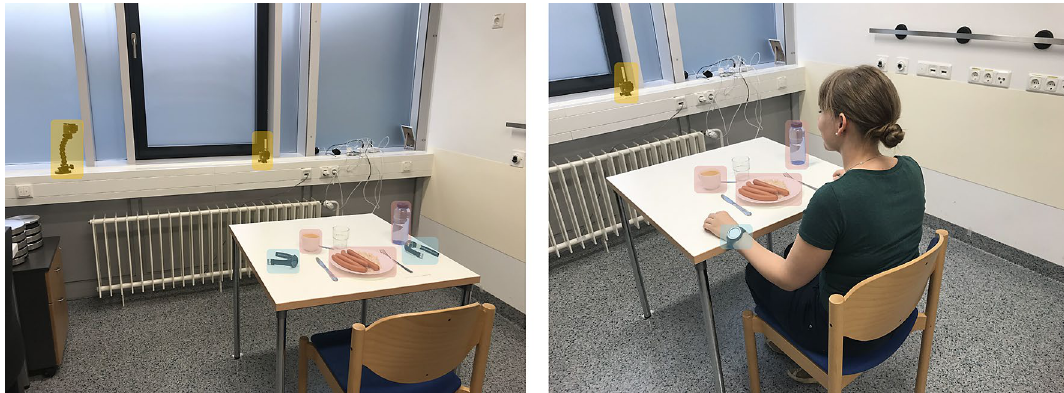
Figure 4. Figures depicting the EaC experiment setup. The picture on the left-hand side highlights the position of the two cameras (yellow). On the right picture, the researcher showcases the position of the smartwatch on the wrist (blue). In both pictures, the contents of the standardized meal are marked